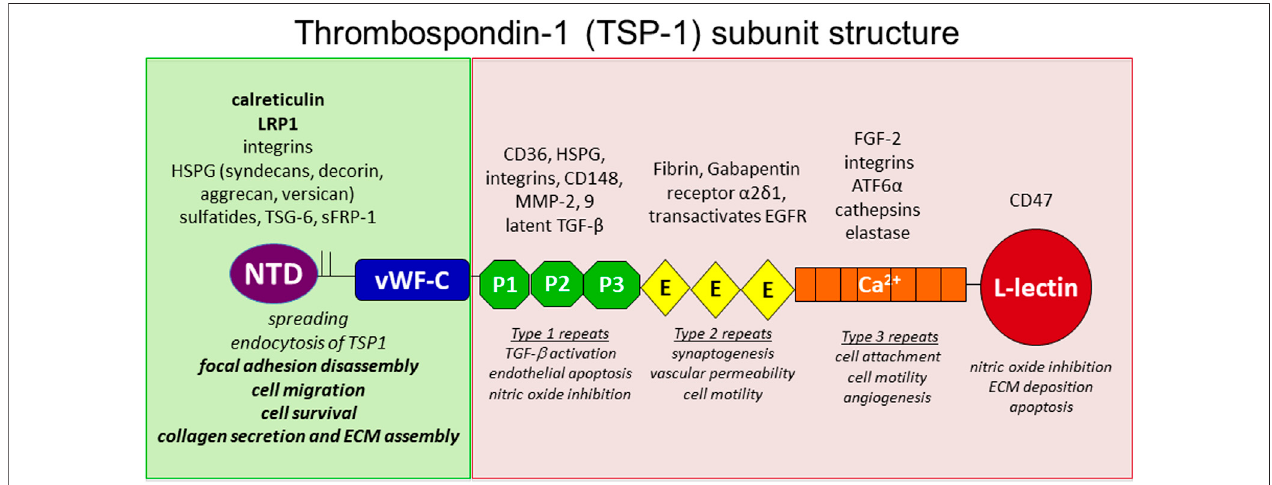
FIGURE 1 | Model of Thrombospondin-1. TSP-1 is a homotrimer linked by interchain disul fi de bonds in the oligomerization domain between the laminin G like N-terminaldomain(NTD)andthevWF-Clikedomain.Itiscomprisedof3properdin-likerepeats(alsocalledTSRorType1repeats),followedby3EGF-likerepeats(Type 2 repeats). This is followed by 13 calcium-binding Type 3 repeats that interact with the C-terminal L-lectin like domain. Various receptors and interacting molecules for each domain are indicated above the structure and functions ascribed to each domain are indicated below the